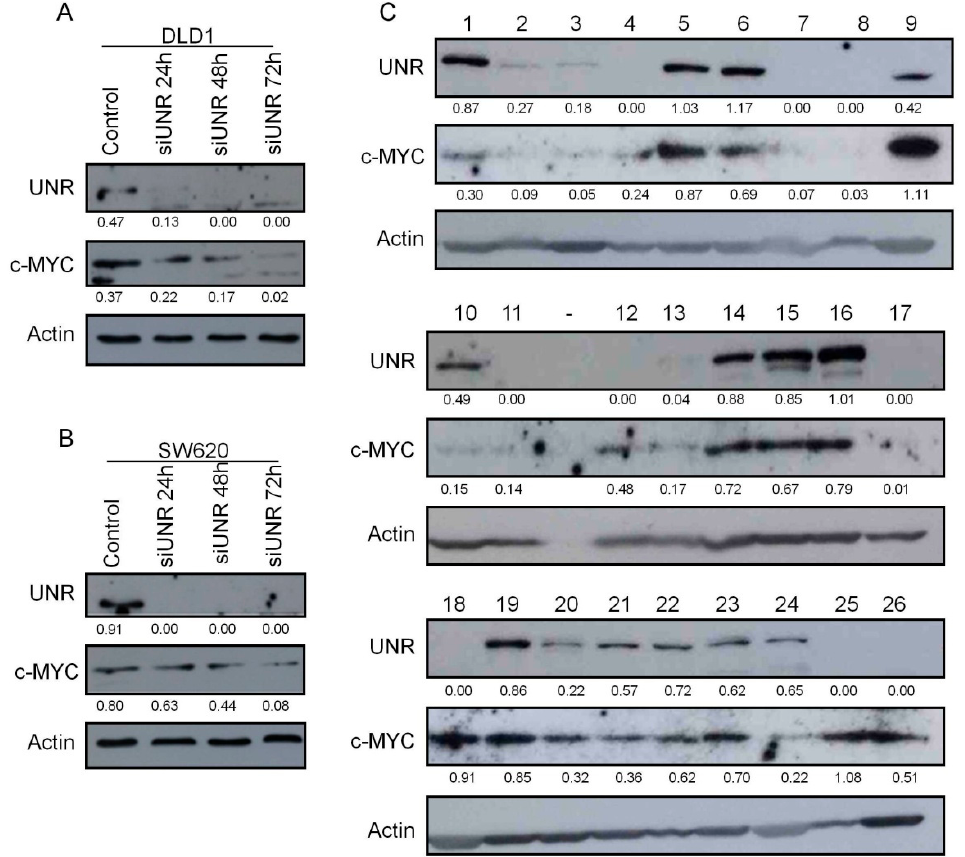
Figure 6. c-MYC protein expression is associated to UNR protein expression in CRC derived cell lines and patients. ( A , B ) UNR and c-MYC protein expression in DLD1 and SW620 cell lines were evaluated at 24, 48, and 72 h after UNR downregulation. ( C ) Evaluation of UNR and c-MYC protein expression in 26 human CRC tumor samples (1–26). Protein bands’ quantification is shown under each band.